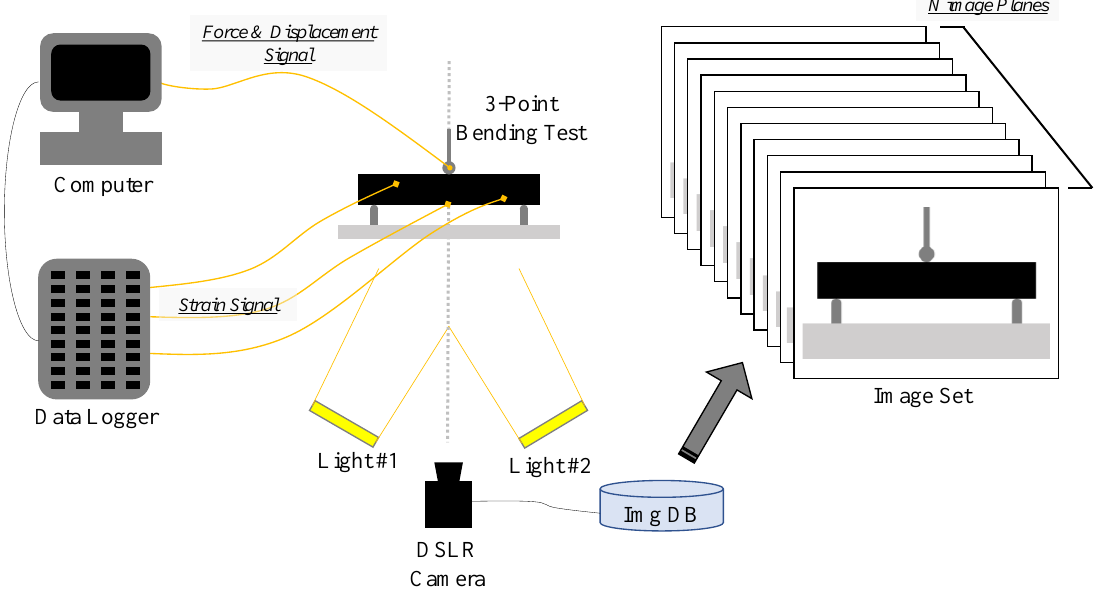
Figure 1. Configuration of the camera image-based measurement and digital image processing experiment.